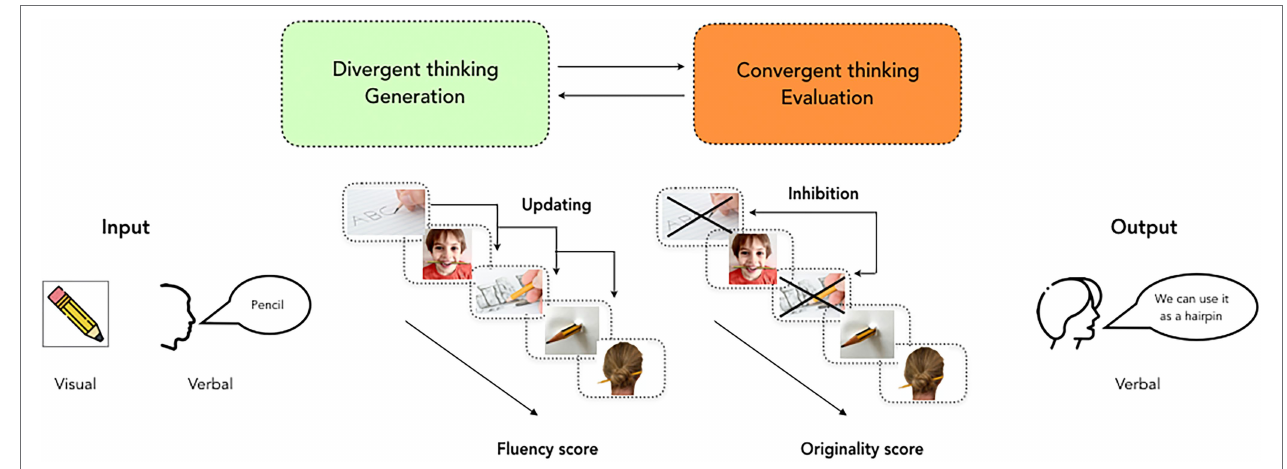
FIGURE 1 | Cognitive processes posited by existing accounts of creativity. Images sourced with permission from Nfsphoto/Dreamstime; Mishoo/Dreamstime. Other images author’s own